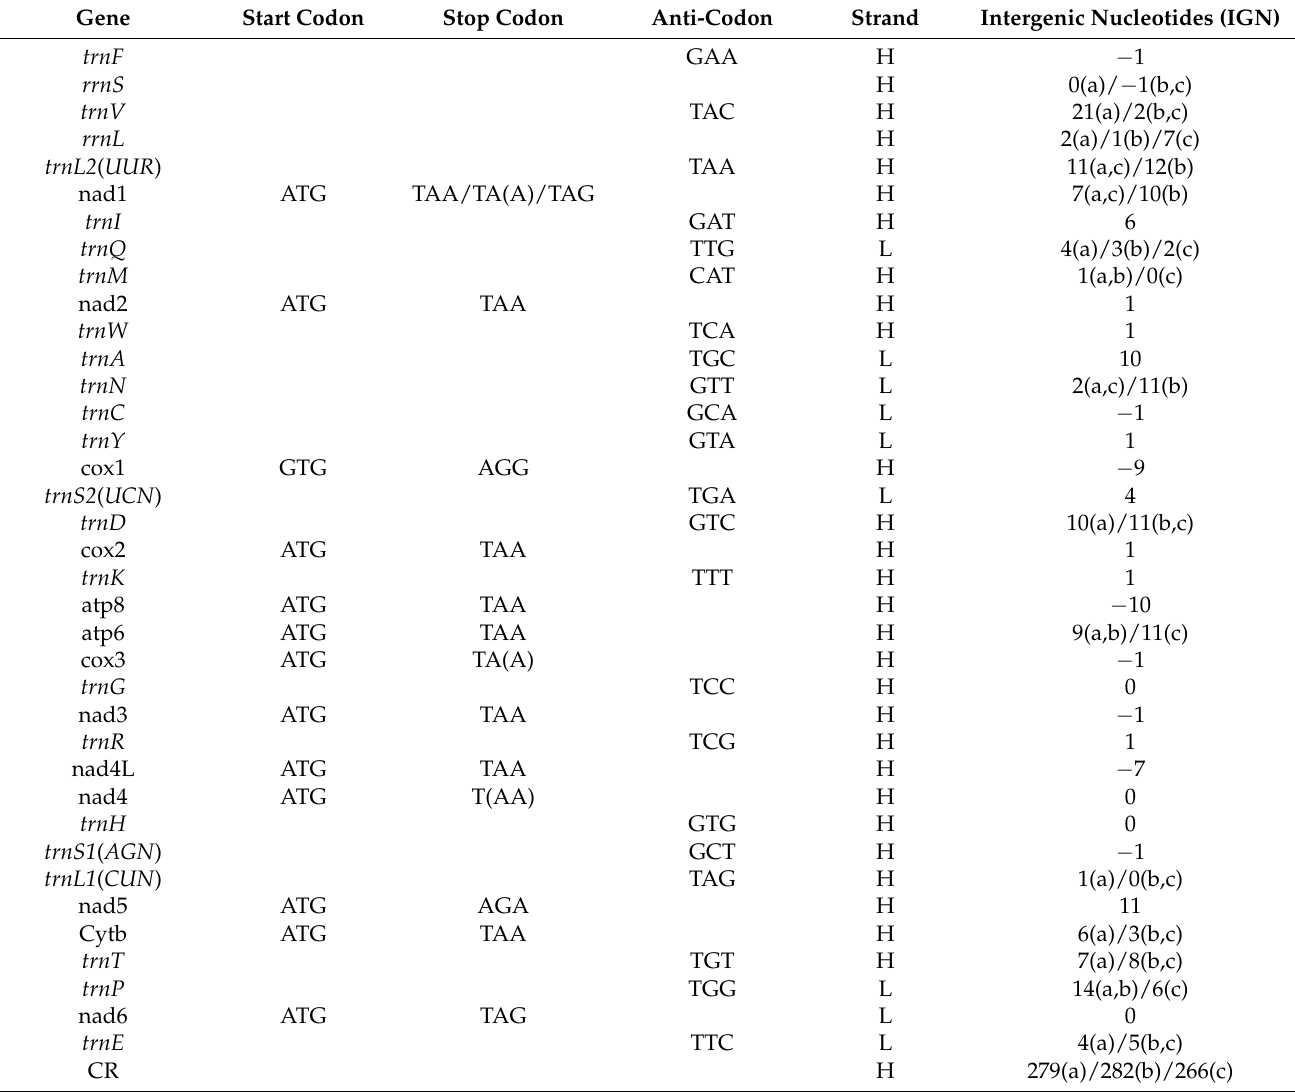
Table 2. Annotation of the complete mitogenome of the three Sitta species in this study.